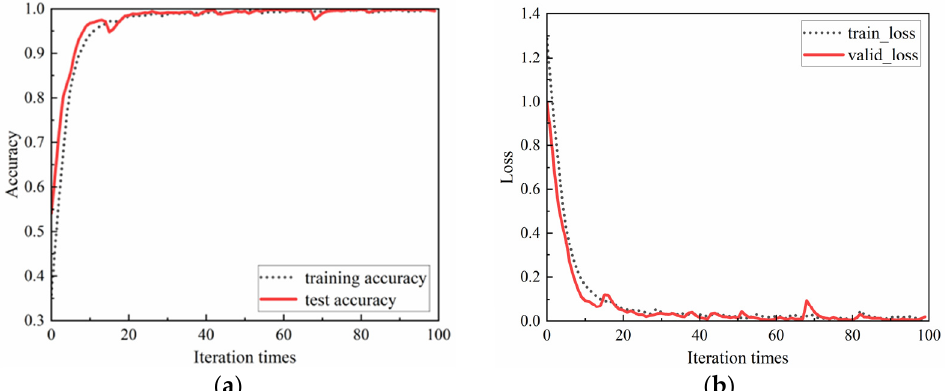
Figure 11. Accuracy changes and loss changes of training set and test set. ( a ) Accuracy changes. ( b ) Loss changes.